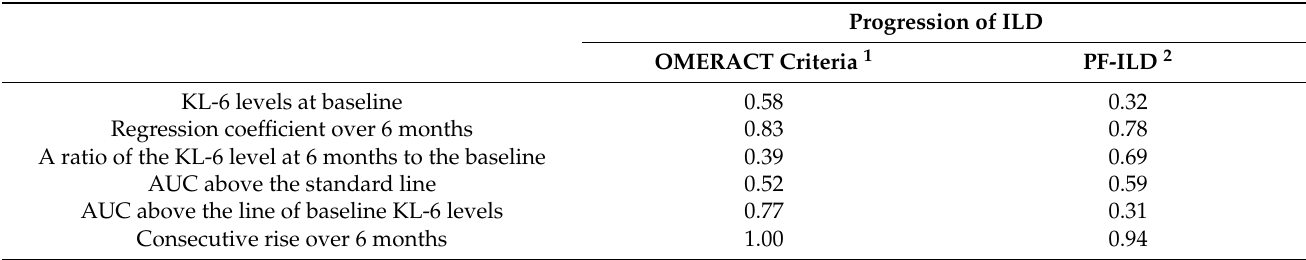
Table 4. Correlations between baseline KL-6 levels or indices for short-term changes in KL-6 levels and ILD progression in 64 patients with